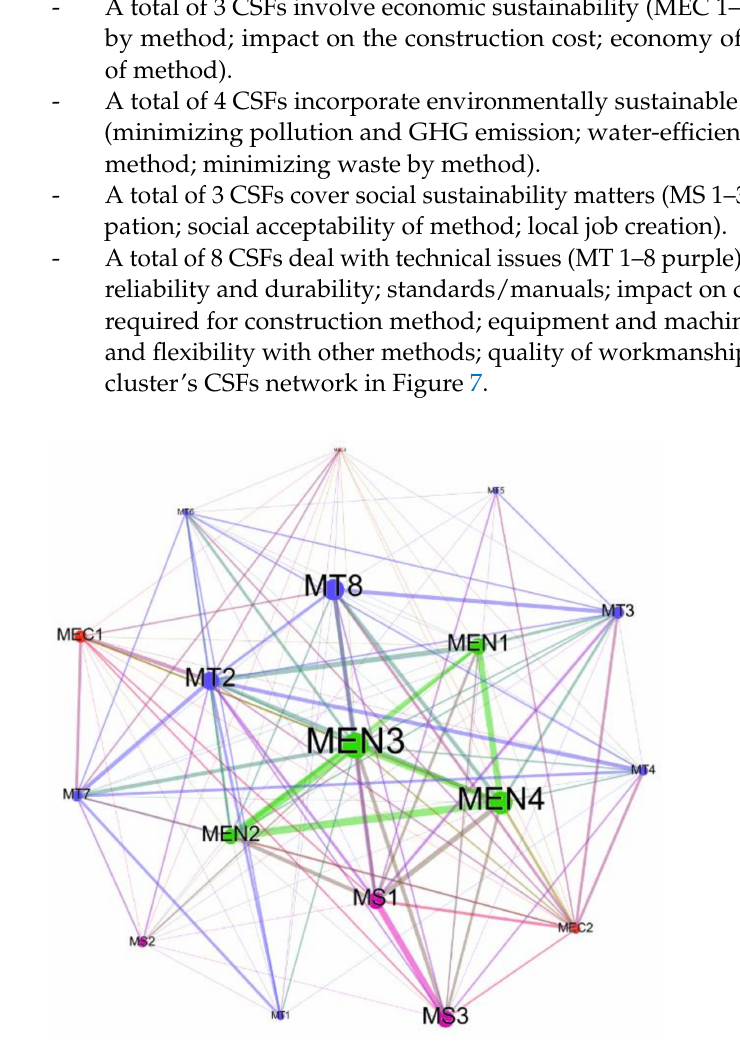
Figure 7. Method CSFs